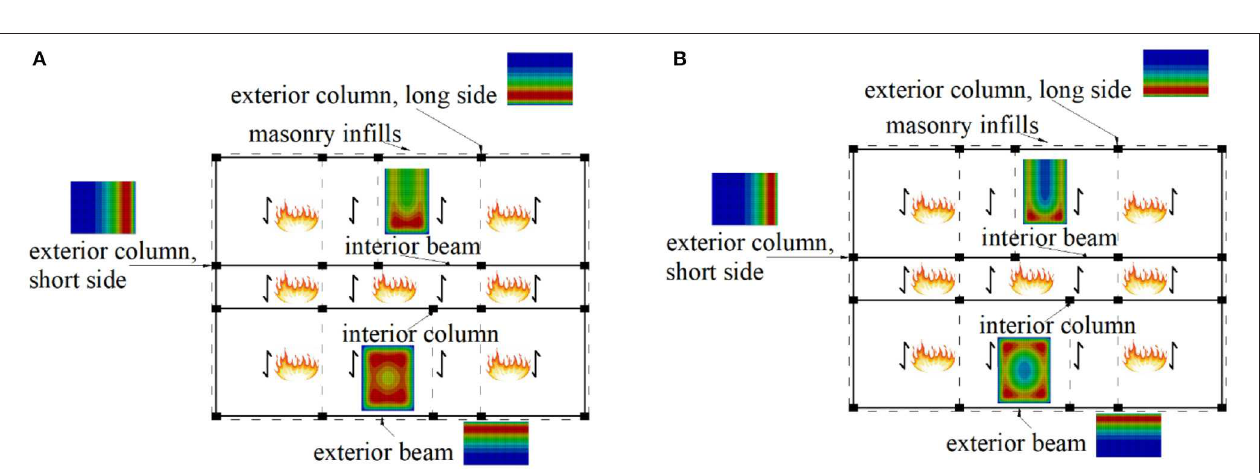
FIGURE 2 | Fire compartments for the Collina-Castello school. (A) Fire scenario F0. (B) Fire scenario F1.